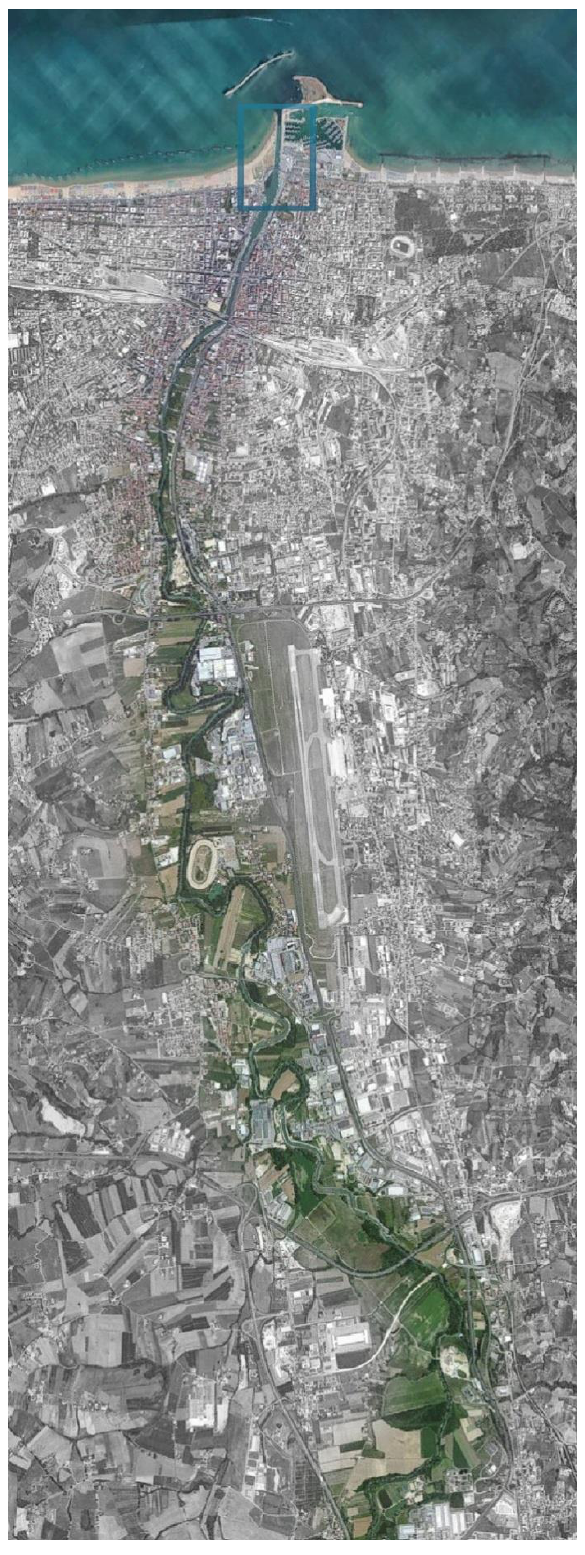
Figure 2: entire area of analysis of the case study on the Pescara-Aterno river